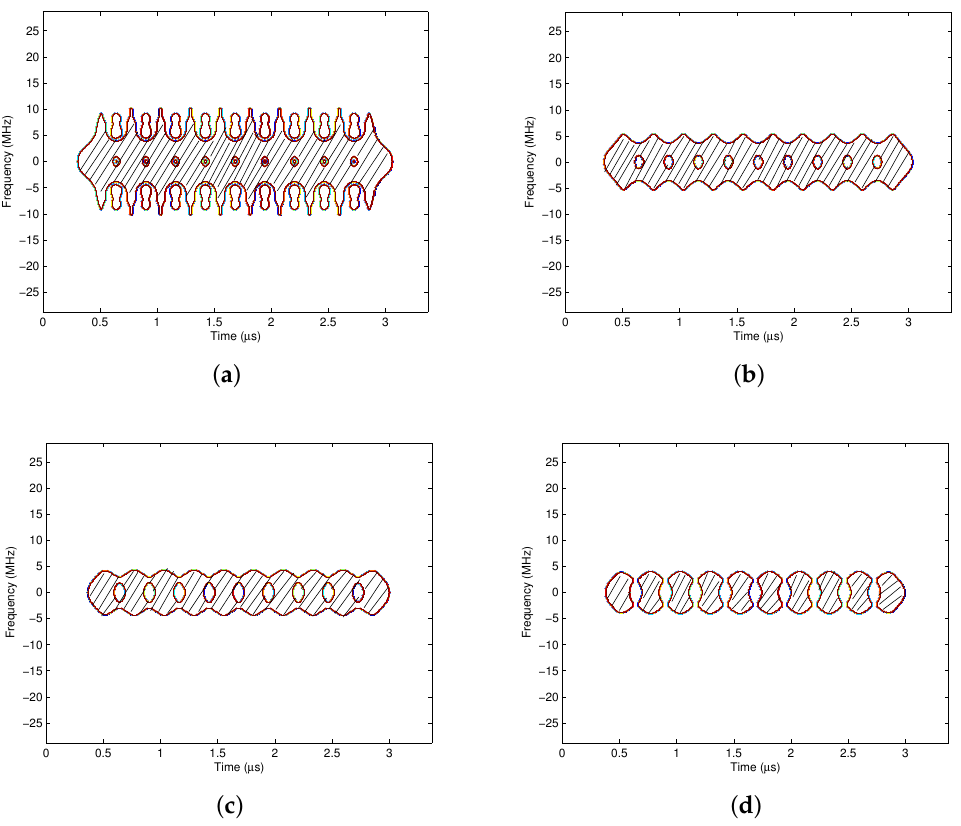
Figure 10. The pass regions with different masking thresholds. ( a ) The pass region with γ = 0.04; ( b ) The pass region with γ = 0.1; ( c ) The pass region with γ = 0.2; ( d ) The pass region with γ = 0.26. The optimal masking threshold γ opt is determined by the minimum bit error rate